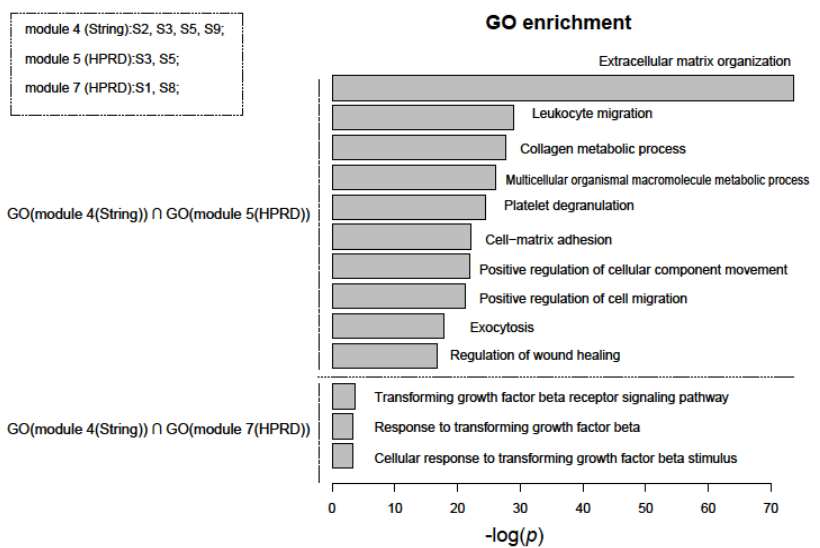
Figure 5. Intersections of enriched gene ontology (GO) terms of network modules containing at least two PGS using functional enrichment analysis. The top ten and only three in total of GO terms (BP) were shown separately in the upper and lower parts of the figure. They were sorted in ascending order of p -value, which were estimated using Fisher’s test and adjusted using FDR, and the final p -value was the larger of the two with common GO term. The top left of the figure also showed which PGS were included in these modules.